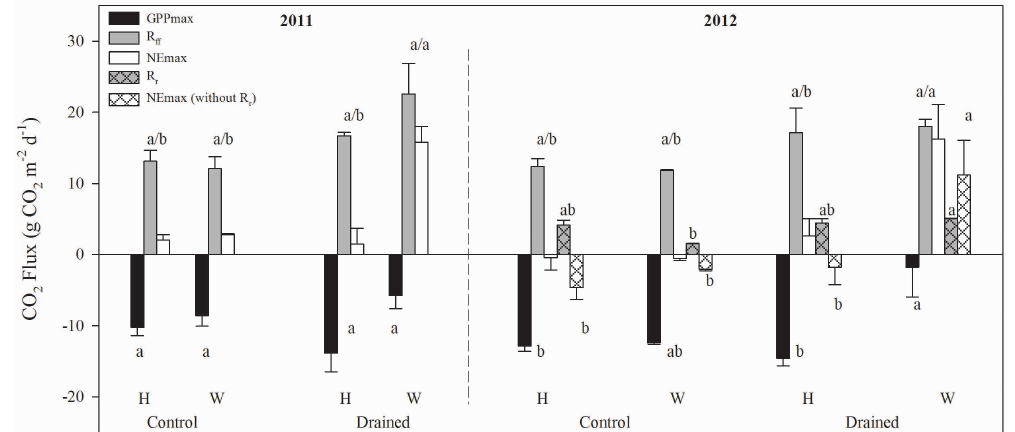
Fig. 4. GPP max , R ff and NE max at control and drained sites in 2011. The R r measurements were added in 2012. NE max (without above- and belowground parts of trees) was calculated by subtracting R r from NE max and represents net exchange of CO 2 of the ground-layer vegetation and peat. H and W represent hummocks and hollows, respectively. Error bars indicate ± standard deviation. Results are from two- way (drainage and microform) ANOVA performed separately for growing season of each year. Differences were evaluated between study plots grouped according to microform and drainage and are indicted by letters at each bar. Sites are significantly different at p < 0.05 if they have no letters in common (letters should be compared only within one CO 2 component in one